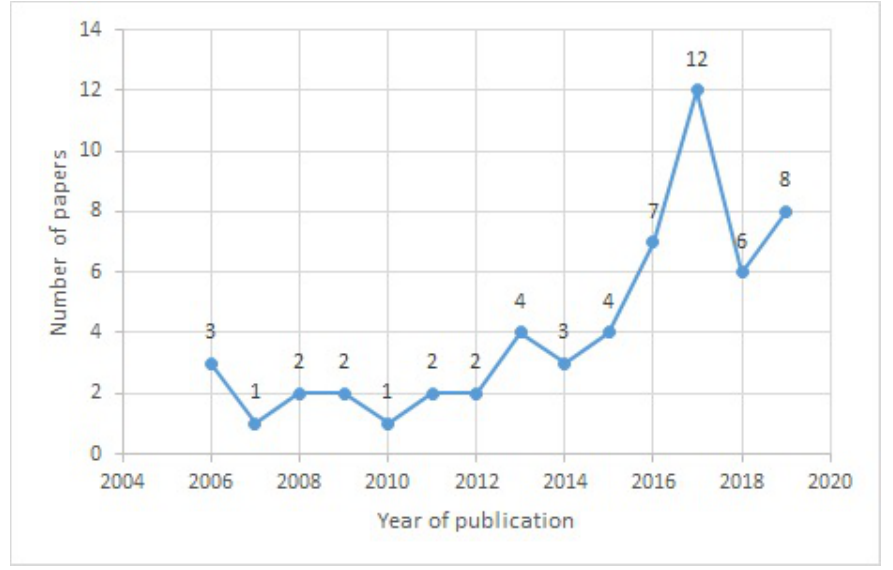
Figure 6. Number of publications by